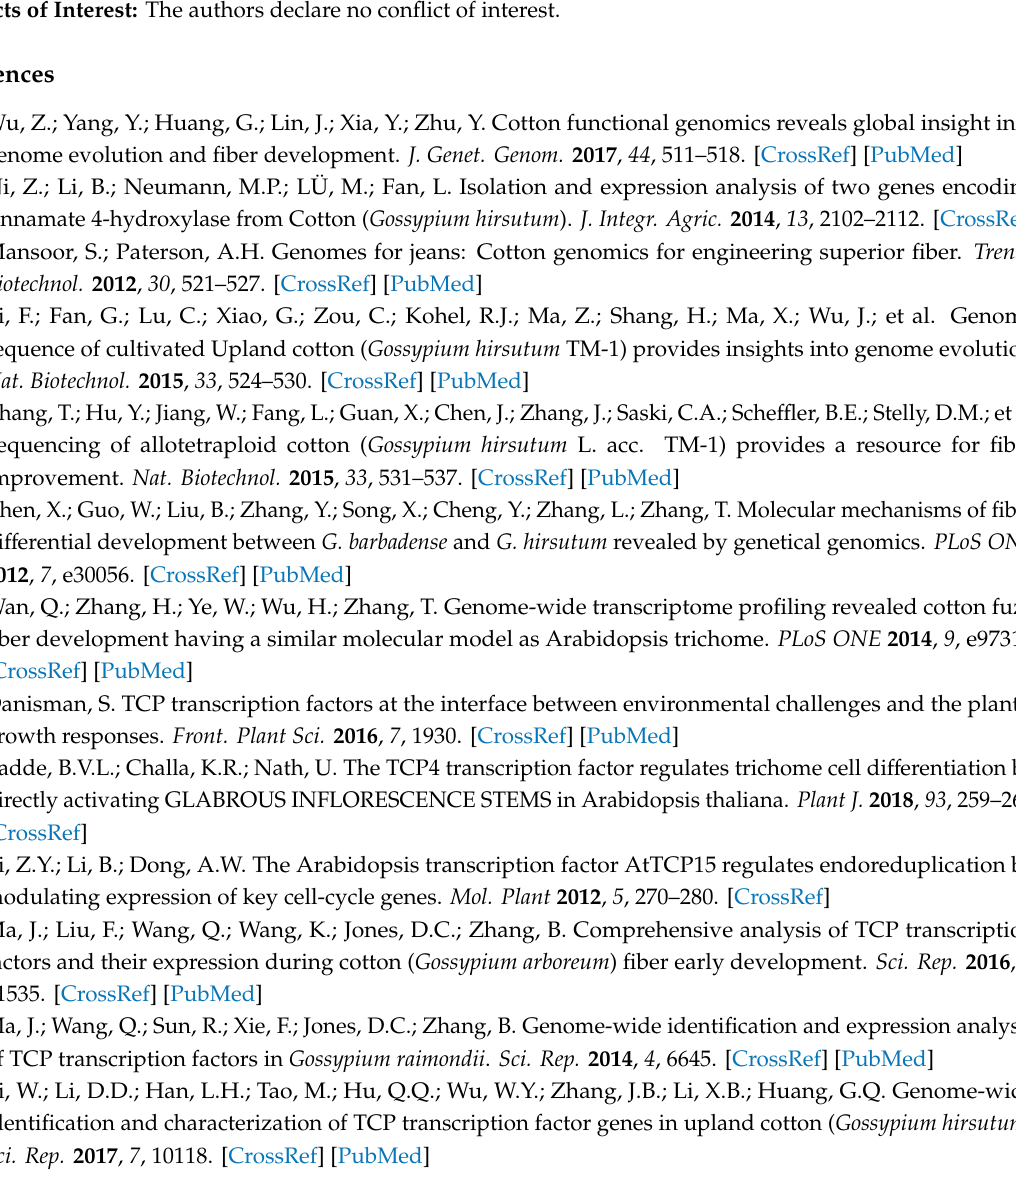
Figure S1: The promoter sequences of GbTCP4 . The predicted TCP-binding site is represented by yellow, Table S1: Primer sequences used in this study, Table S2: Data for measuring the number and length of root hair. Author Contributions: Z.N. and Y.Y. conceived and designed the experiments. Q.C., G.B., and Y.Q. collected the plant materials. Z.N., Y.Y., Y.W., and W.G. performed the experiments. Y.Y., Z.N., and Y.W. analyzed the data. Z.N., Y.Y., and Y.W. wrote the